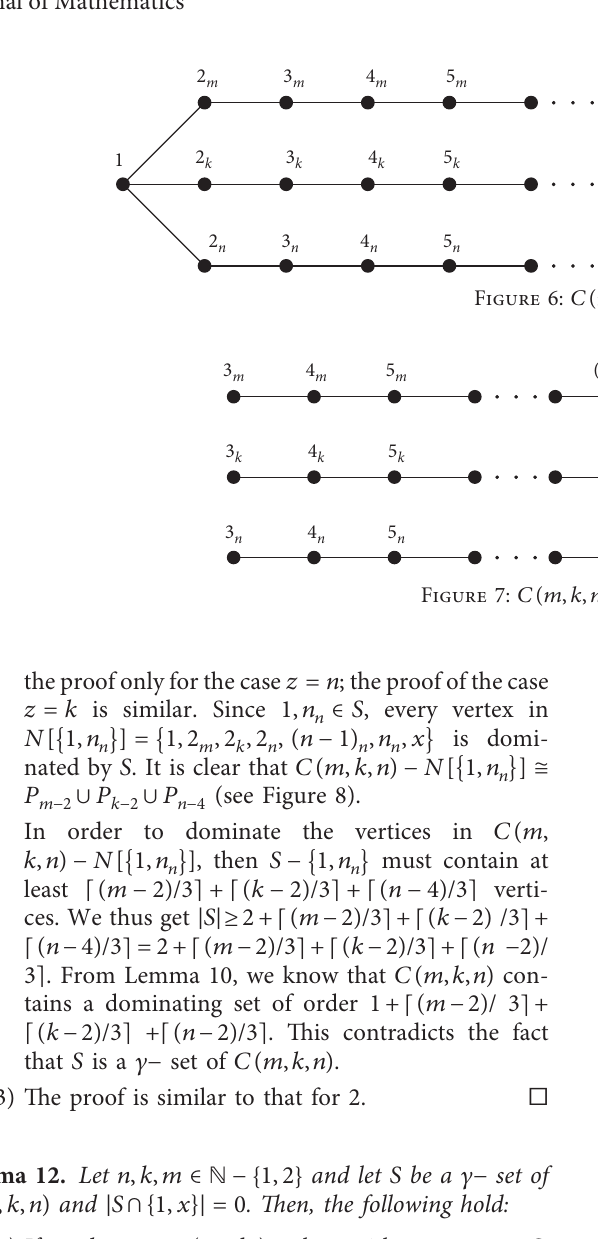
Figure 6: C ( m,k, n )